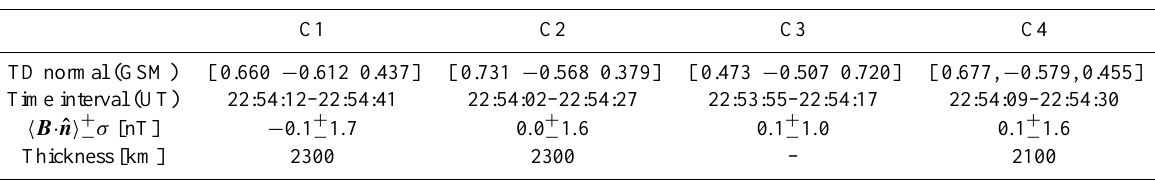
Table 2. The tangential discontinuity normals of the boundary and the time intervals used to find them, for each of the spacecraft. In the third row the average magnetic field components along the normals and their standard deviations are given. The fourth row shows the estimated thickness of the boundary.